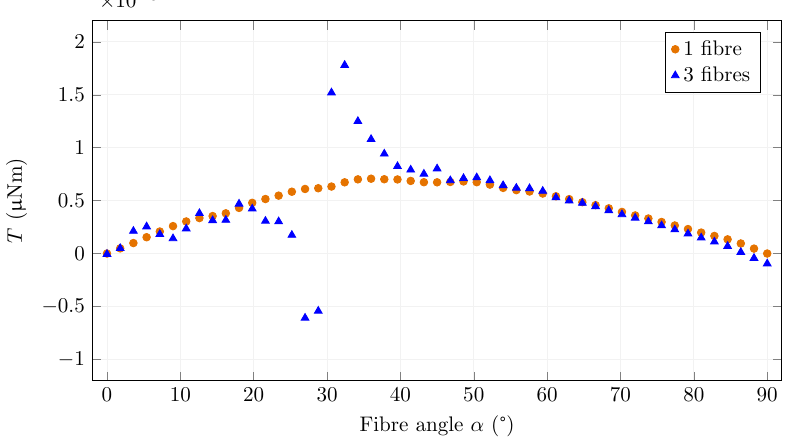
Figure 13. Torque and fibre angle relationship for one and three fibres for B 0 = 0.1 mT. The fibres become saturated when the strength of the magnetic field increases (Figure 14). In this case, the difference between the torque acting on a single fibre and the torque of the field deformed by the added fibres is smaller. The reason for this phenomenon is that the torque depends on the magnetic induction in the fibre. The magnetic induction increases in the nonsaturated state. However, it is practically constant in the saturated state except for angles close to 90 ◦ . Nevertheless, the tendency to align with the other fibres is present.